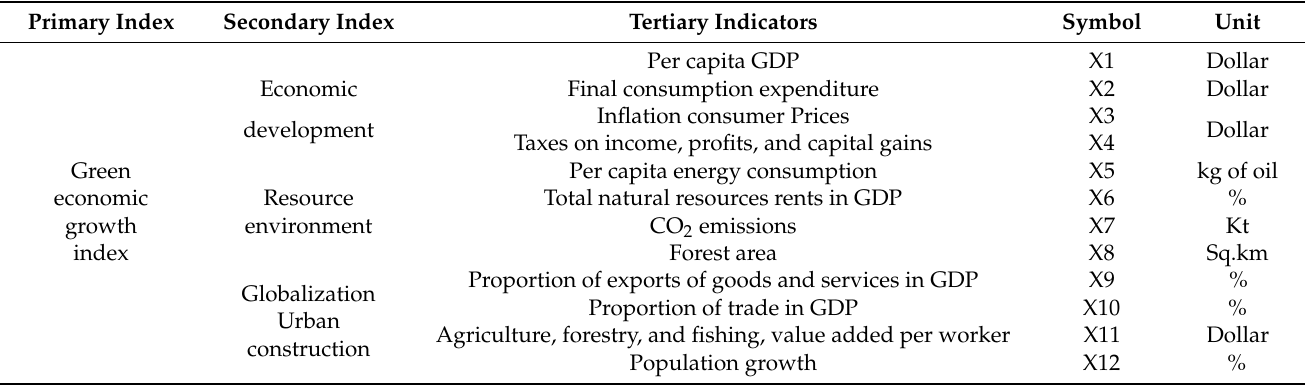
Table 1. Indicator system of green economic